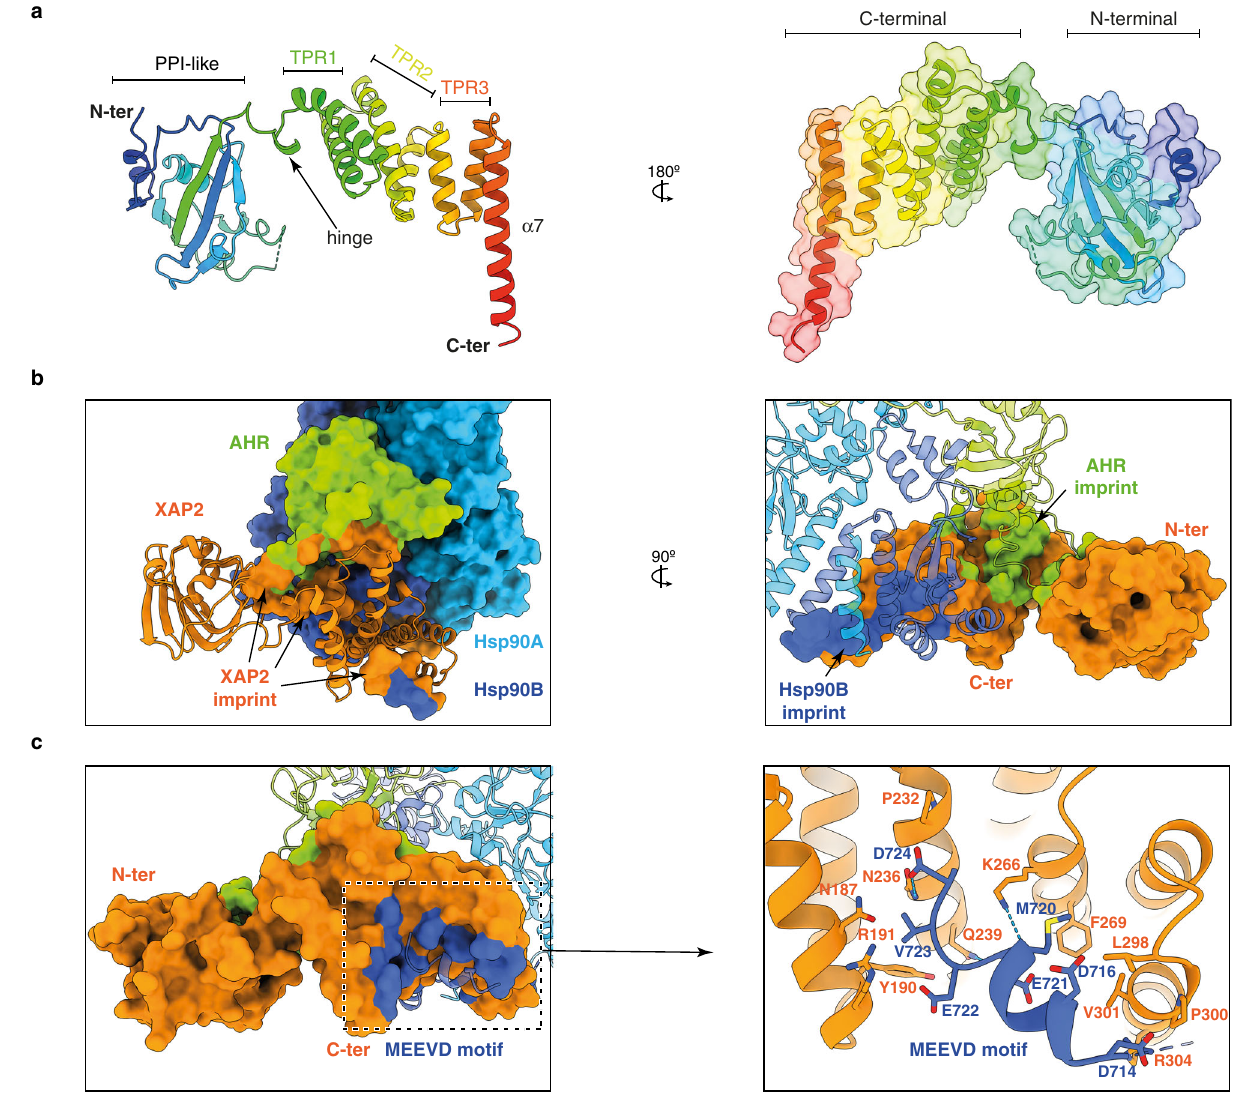
Fig. 5 | Detailed analysis of XAP2 protein and its interactions with the other partners. a Cartoon representation of XAP2 protein in two views coloured in rainbow from N- to C-terminus. Location of the most important features is indi- cated. XAP2 is composed of two domains that are separated by a short hinge. The N-terminaldomainisnotverywellde fi nedinthecryo-EMmapmostlikelyduetoits increased mobility. The alpha-helical C-terminal domain is forming extensive contacts with both AHR and Hsp90 and is much better de fi ned. PPI-like — peptidyl- prolylisomerase-likedomain.TPR1,2and3 — tetratricopeptiderepeatmotif1,2and 3, α 7 — C-terminal helix alpha. b XAP2 is interacting extensively with two other proteins.Leftpanel:ImprintoftheXAP2ontheothercomponentsofthecomplex.